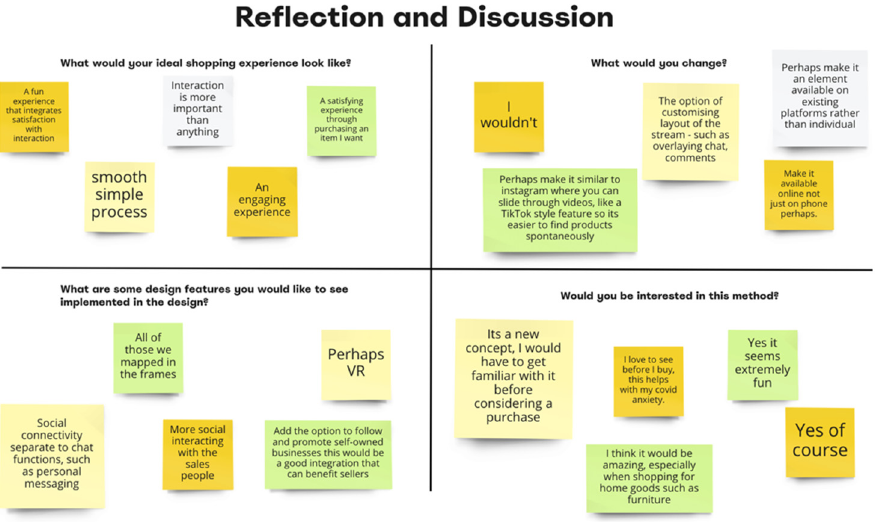
Figure 13. A screenshot from the Co-Design Workshop Miro board, illustrating participants reflection and discussion.